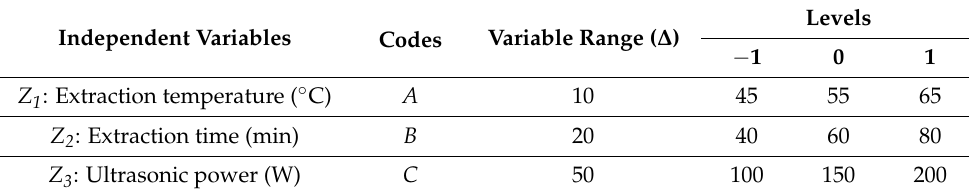
Table 1. Independent variables and their corresponding levels.